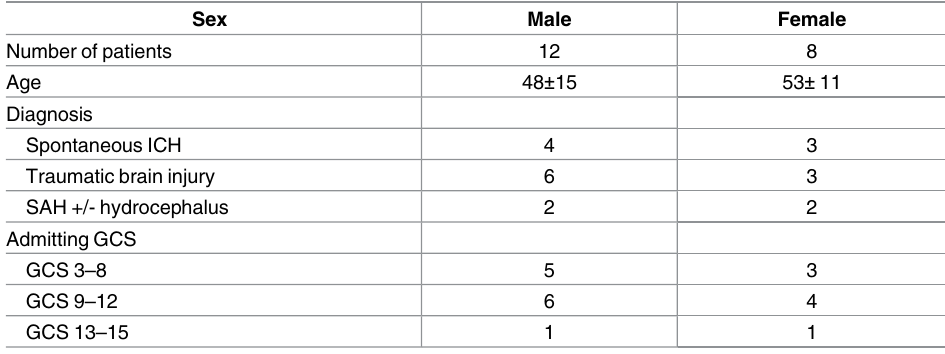
Table 1. Demographic details of 20 patient.